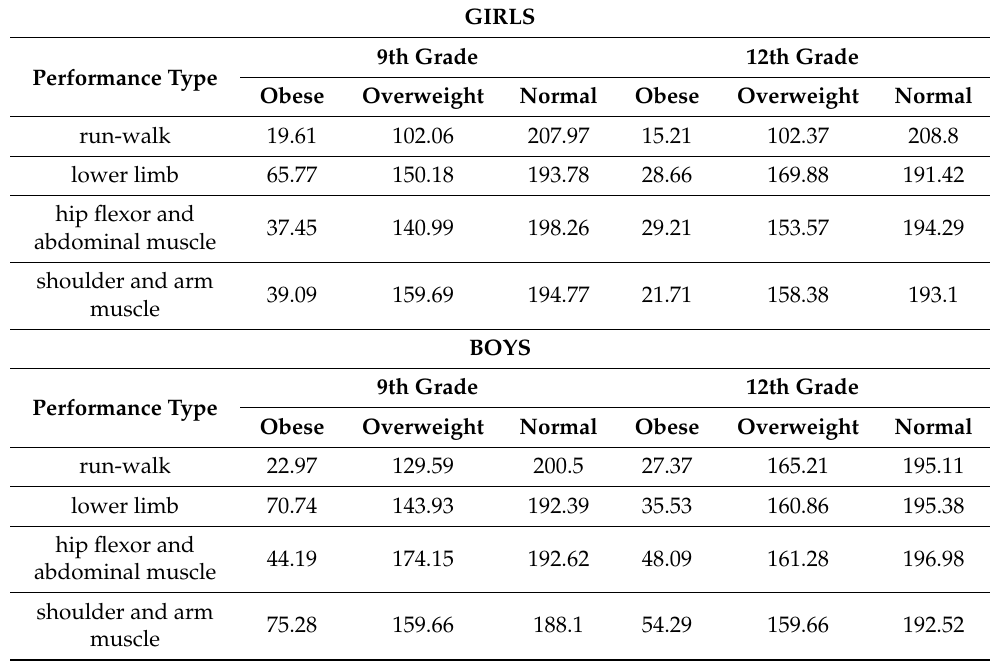
Table 1. Mean rank values by the Kruskal–Wallis test for between weight-group